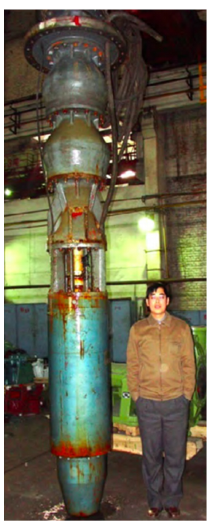
Figure 8. A two-stage lifting pump of China.